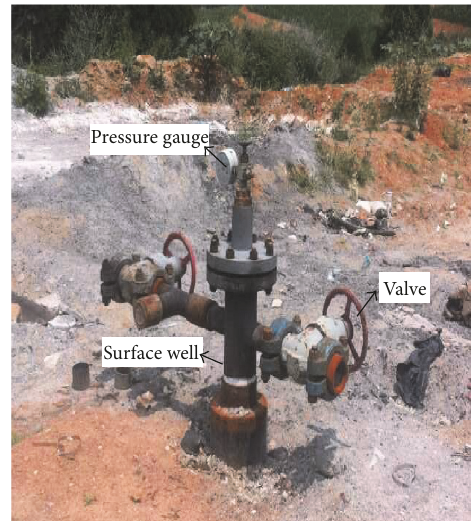
Figure 5: Setup for field measurement of residual methane pressure in abandoned mine gobs.